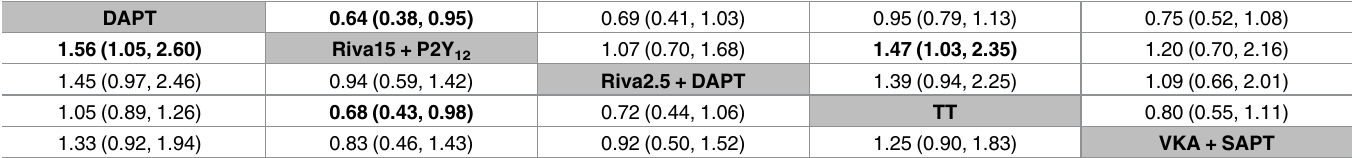
Table 2. NMA results of MACCEs risk for all treatments relative to each other under the consistency